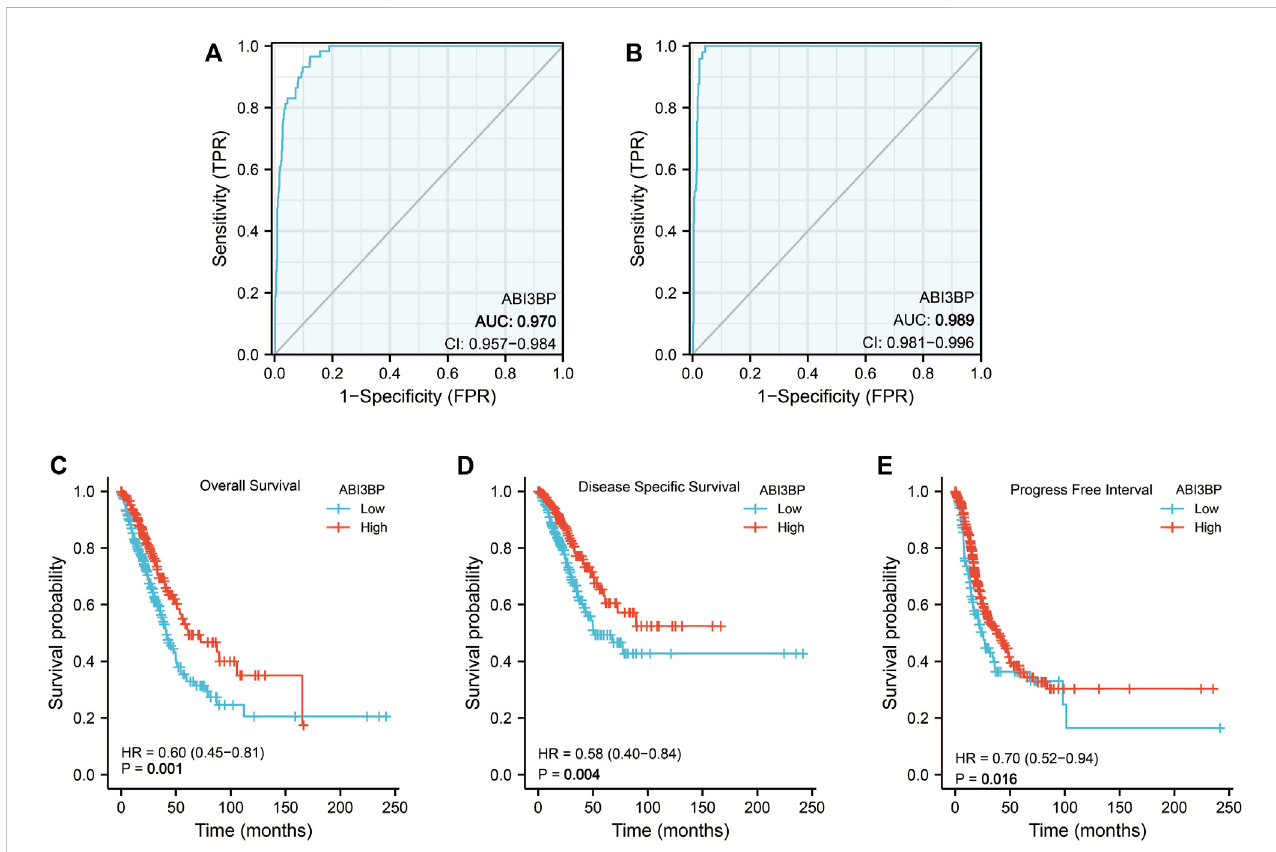
FIGURE 2 Diagnostic and prognostic value of ABI3BP. (A, B) Diagnostic ROC curve of ABI3BP in lung cancer. (C – E) Prognostic K-M curve of ABI3BP in lung cancer.